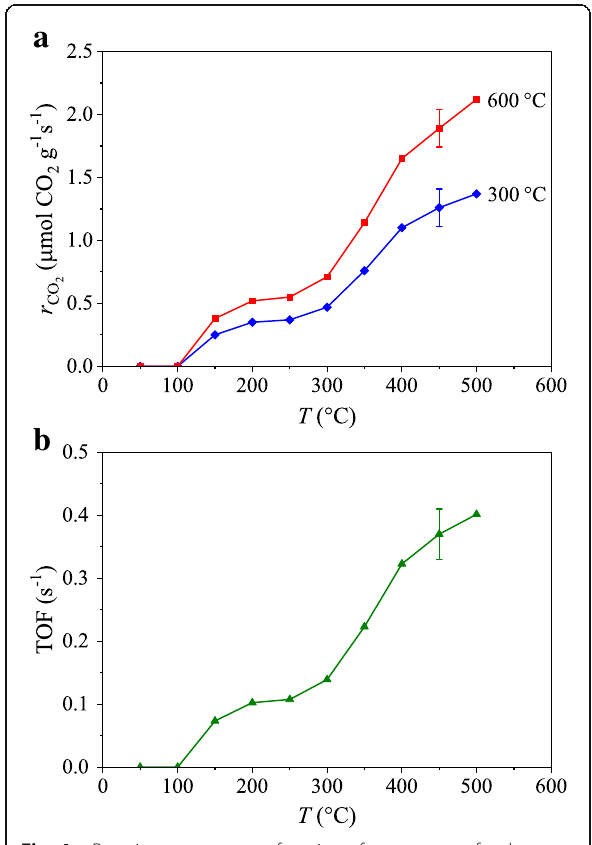
Fig. 4 a Reaction rate r CO as a function of temperature for the 2 Ga 3 Ni 2 catalyst reduced at 300 or 600 °C, respectively. b The CO 2 turnover frequency (TOF) as a function of